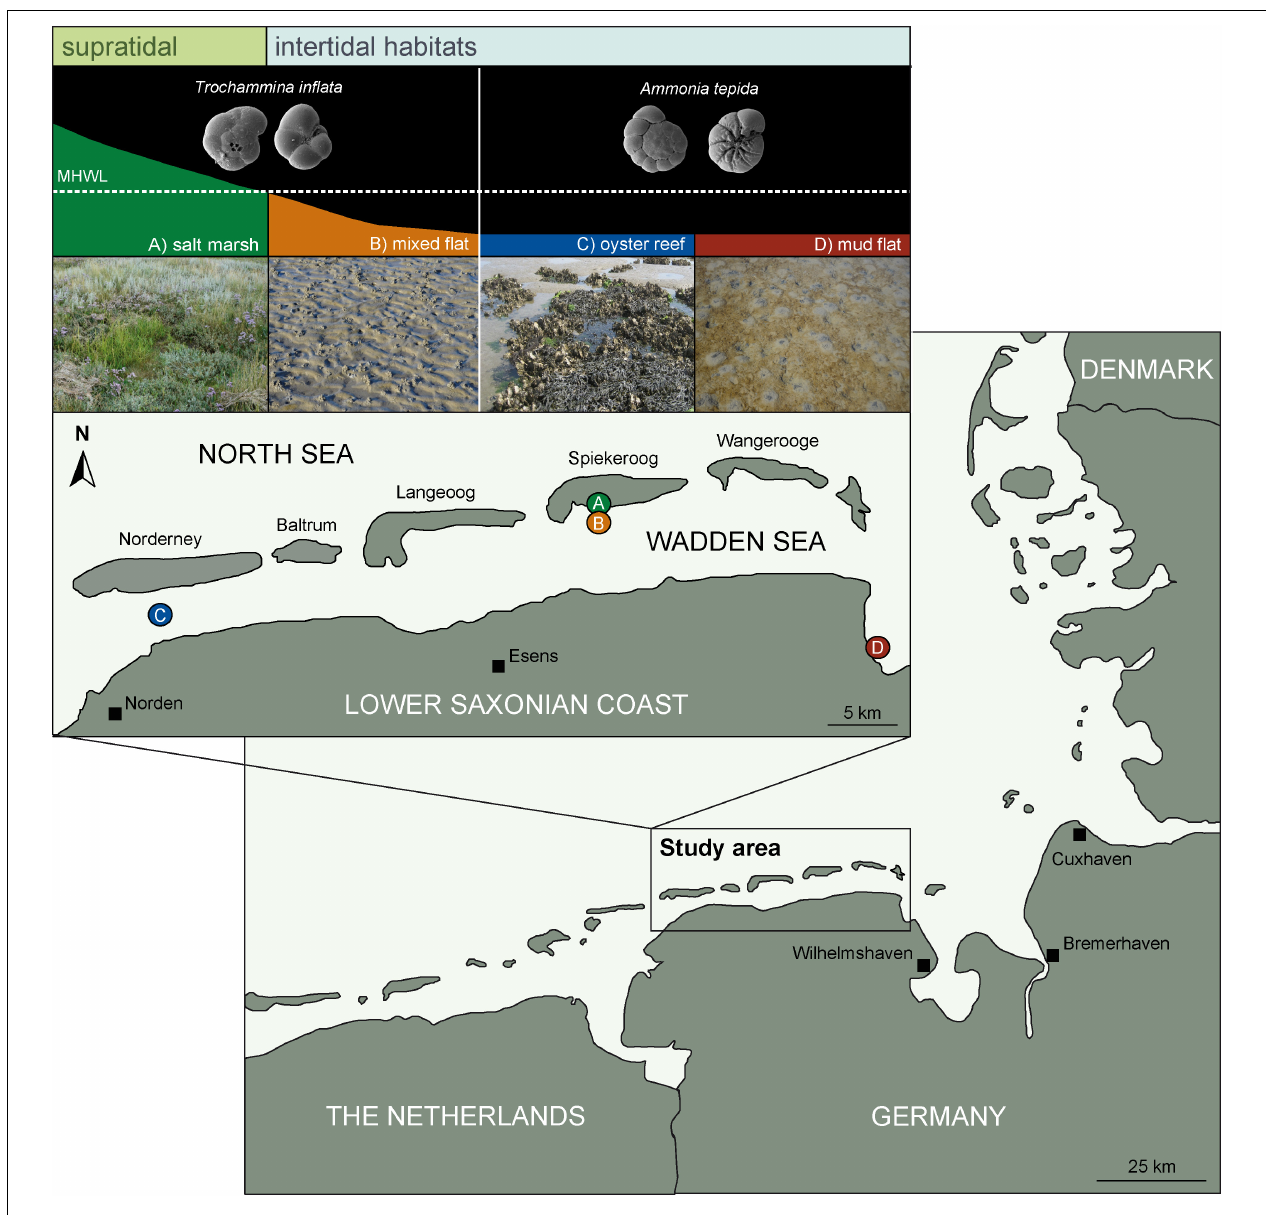
FIGURE 1 | Map of study site including the four characteristic habitats of the Wadden Sea. Supratidal: (A) salt marsh = green, intertidal: (B) mixed flat = orange, (C) oyster reef = blue and (D) mud flat = dark red, which are located in the backbarrier environment of the East Frisian Islands of the central Wadden Sea (Germany, Southern North Sea). Small pictures represent the agglutinated species Trochammina inflata dominating in lower supratidal to higher intertidal (salt marsh and the mixed flat) and the hyaline species Ammonia tepida inhabiting the lower intertidal and subtidal (oyster reef and the mud flat).